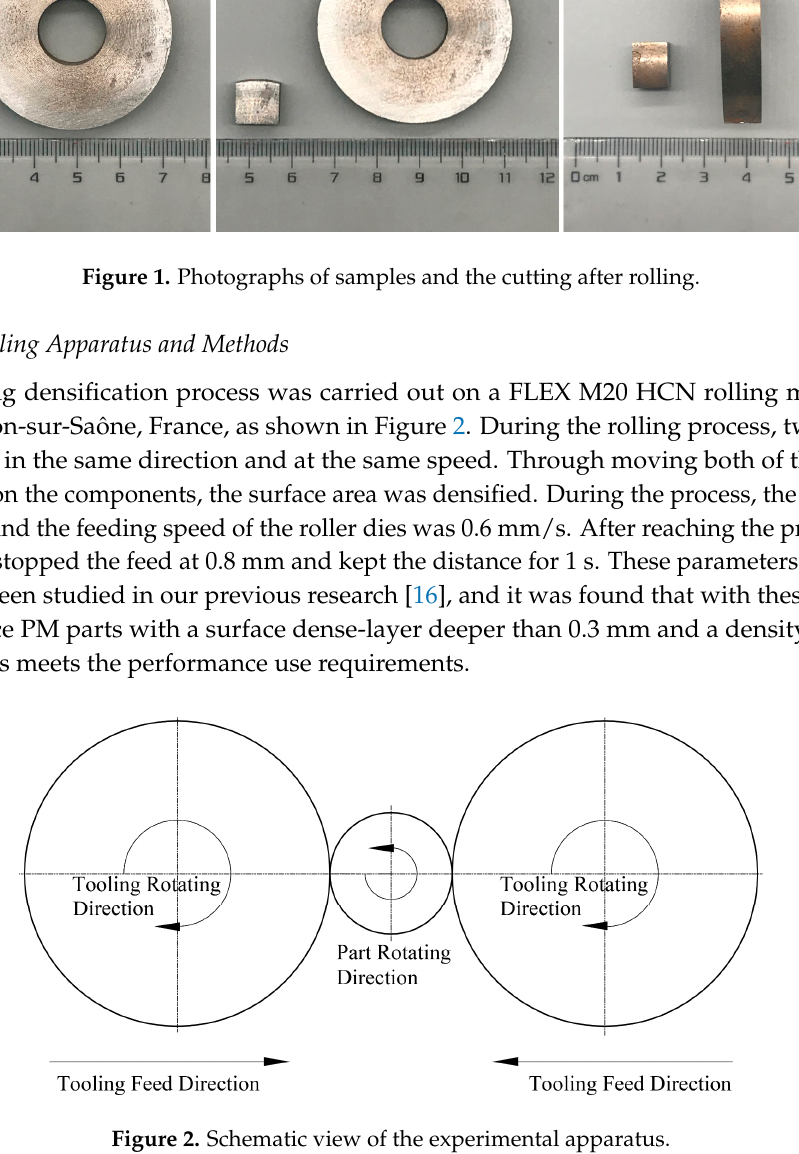
Figure 2. Schematic view of the experimental